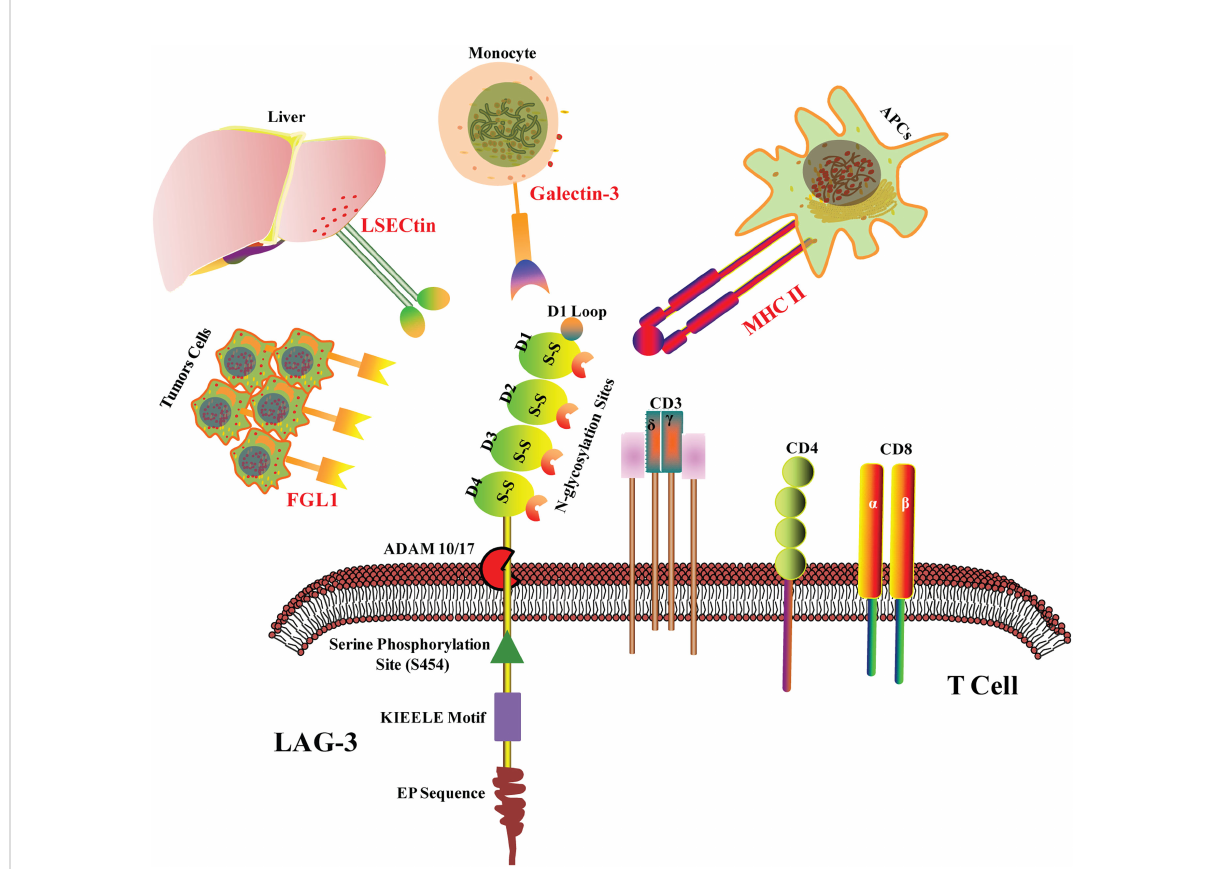
FIGURE 1 LAG-3 structure and ligands. LAG-3 consists of extracellular region, transmembrane region and cytoplasmic region. The extracellular domain is composed of four IgSF domains, namely D1, D2, D3 and D4. The D1 domain contains a loop domain rich in proline and an in-chain disul fi de bond. In the transmembrane- cytoplasmic part, LAG-3 breaks away from the cell membrane under the action of metalloproteinases ADAM10/ 17. The cytoplasmic region of LAG-3 consists of three parts: the serine phosphorylation site S454, the highly conserved “ KIEELE ” motif and the glutamate-proline dipeptide repeat motif (EP sequence). MHC II, Galectin-3, LSECtin and FGL1 are the con fi rmed ligands of LAG-3 in tumor